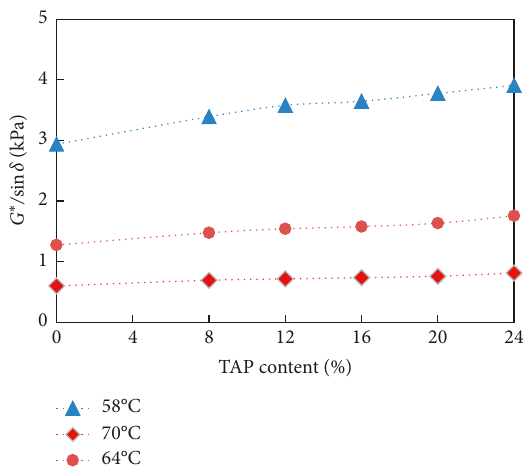
Figure 10: Variation in the G ∗ /sin δ value of TAP-modified asphalt with TAP content.